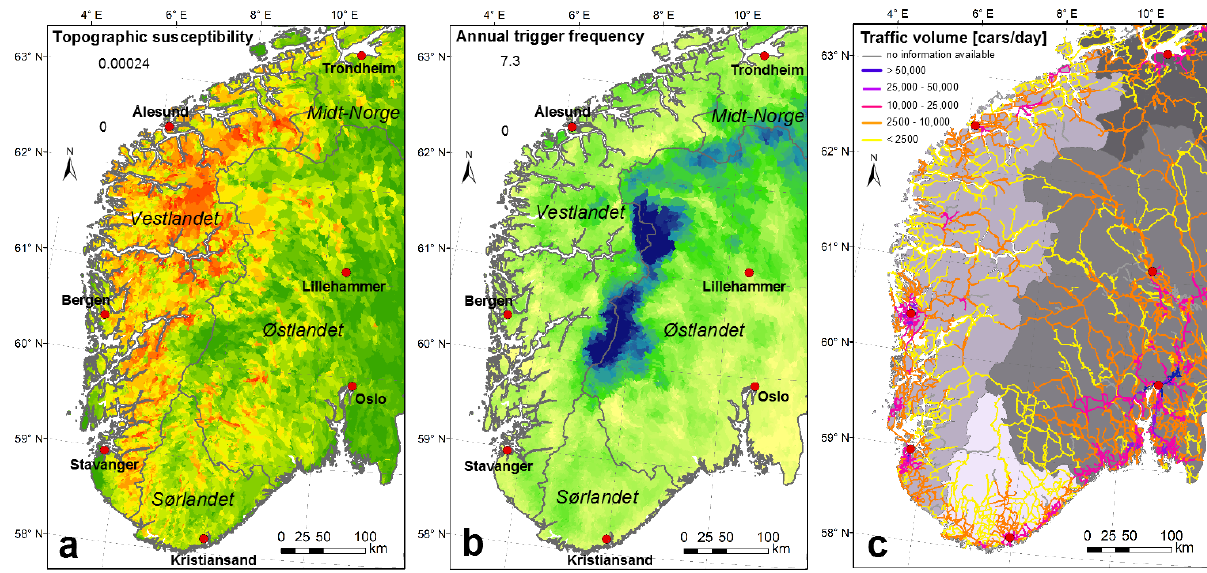
Figure 2. (a) Topographic susceptibility, i.e. aggregated probability of debris-flow occurrence, in first-order catchments; (b) annual trigger frequency in first-order catchments; (c) average traffic volume per